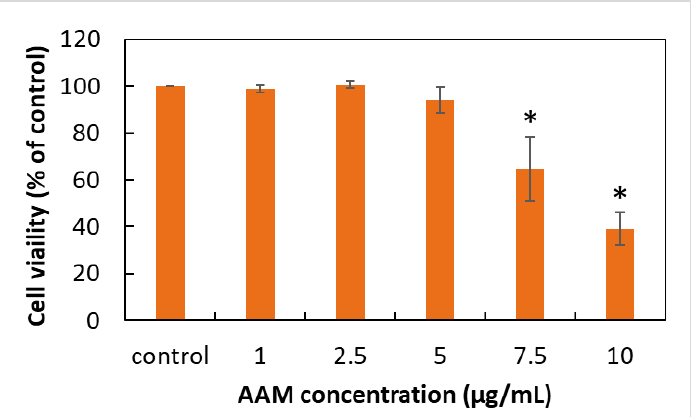
Figure 2. The effects of AAM on HaCaT keratinocytes cell viability. Data were from three independent experiments. Value are mean ± SD ( n = 3). * Significantly different from control group ( p < 0.05).